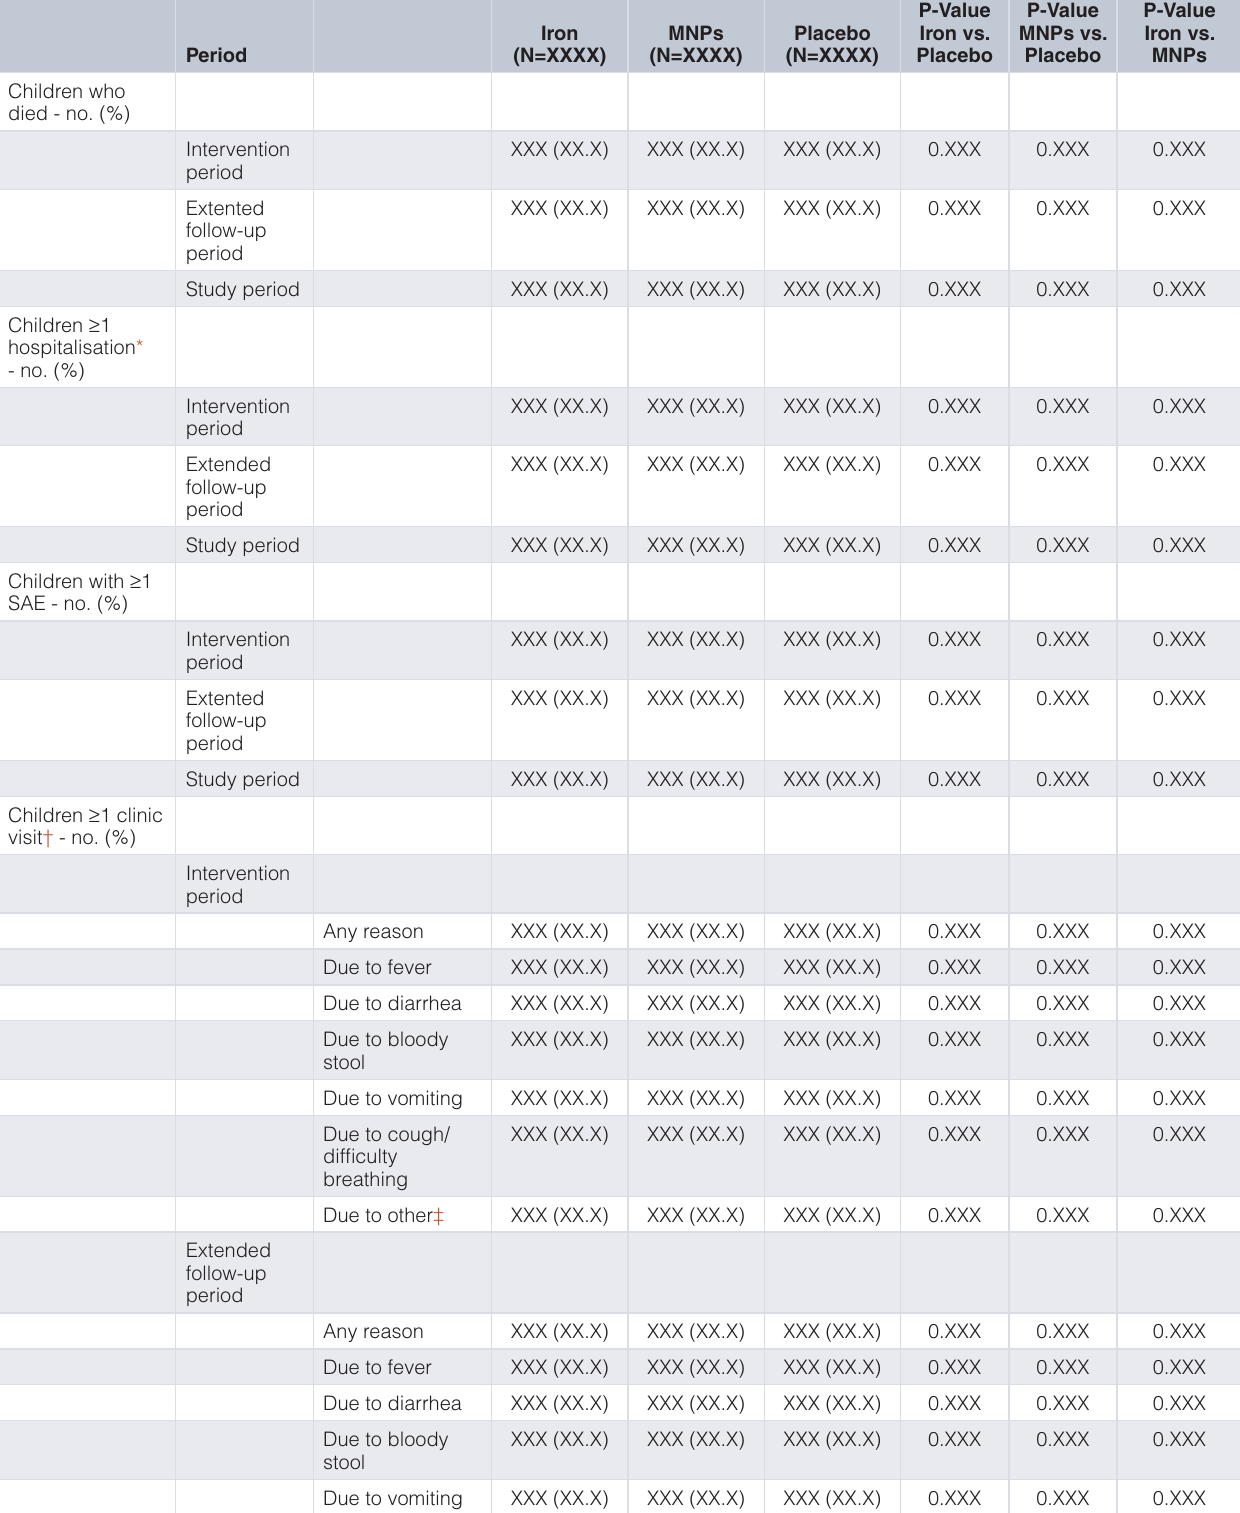
Table 4. Death, serious adverse events, hospitalisation, according to treatment group (safety population).